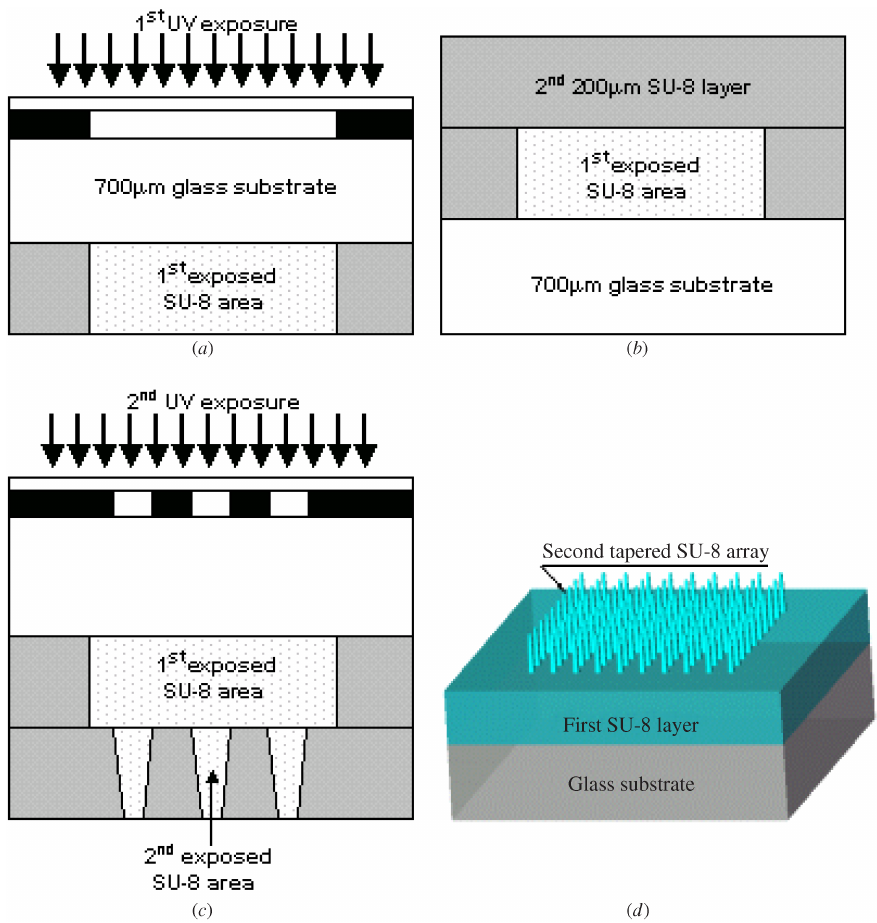
Figure 5. Schematic diagrams of the process flow to fabricate a tapered SU-8 pillar structures: ( a ) first 200 μm thick SU -8 exposure through a glass substrate; ( b ) second 200 μm thick SU-8 layer preparation; ( c ) the second SU-8 layer exposure through the glass substrate and the exposed first SU-8 layer to create an array of tapered SU-8 structures; and ( d ) a